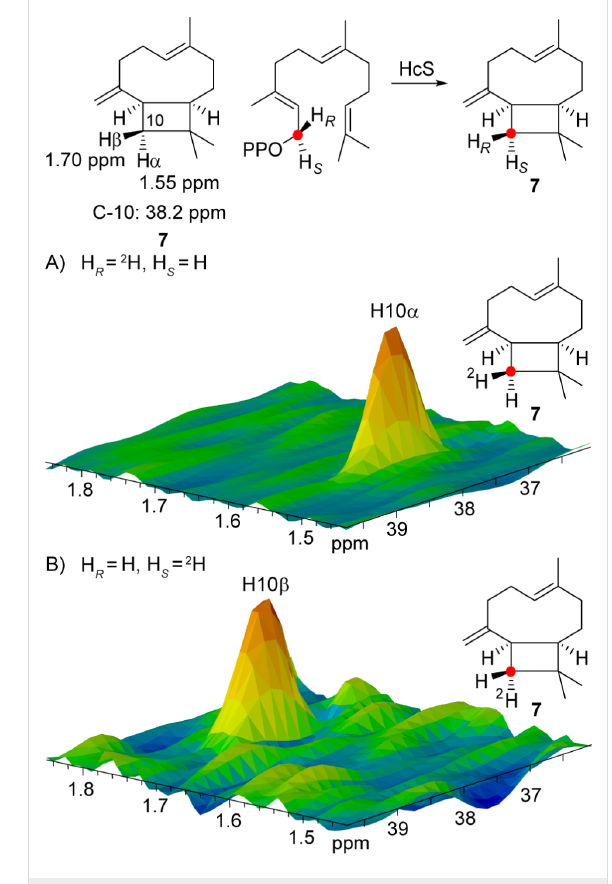
Figure 7: Stereochemical course of the 1,11-cyclisation at C-1 for 7 . Partial HSQC spectra of HcS incubation with A) (1 R )-(1- 13 C,1- 2 H)FPP and B) (1 S )-(1- 13 C,1- 2 H)FPP. The reference chemical shifts for 7 are taken from ref. [44]. Red dots represent 13 C-labelled carbon